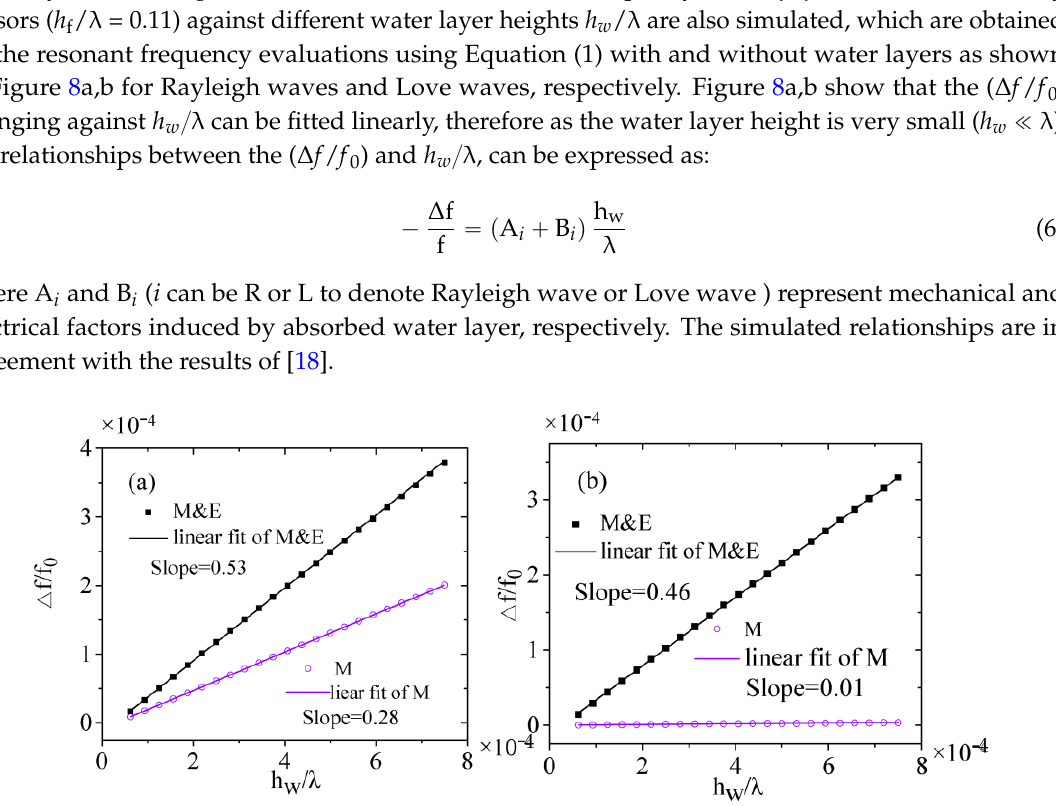
Figure 8. Mechanical and electrical contributions to frequency shift of humidity sensor: ( a ) Rayleigh wave; ( b ) Love wave.